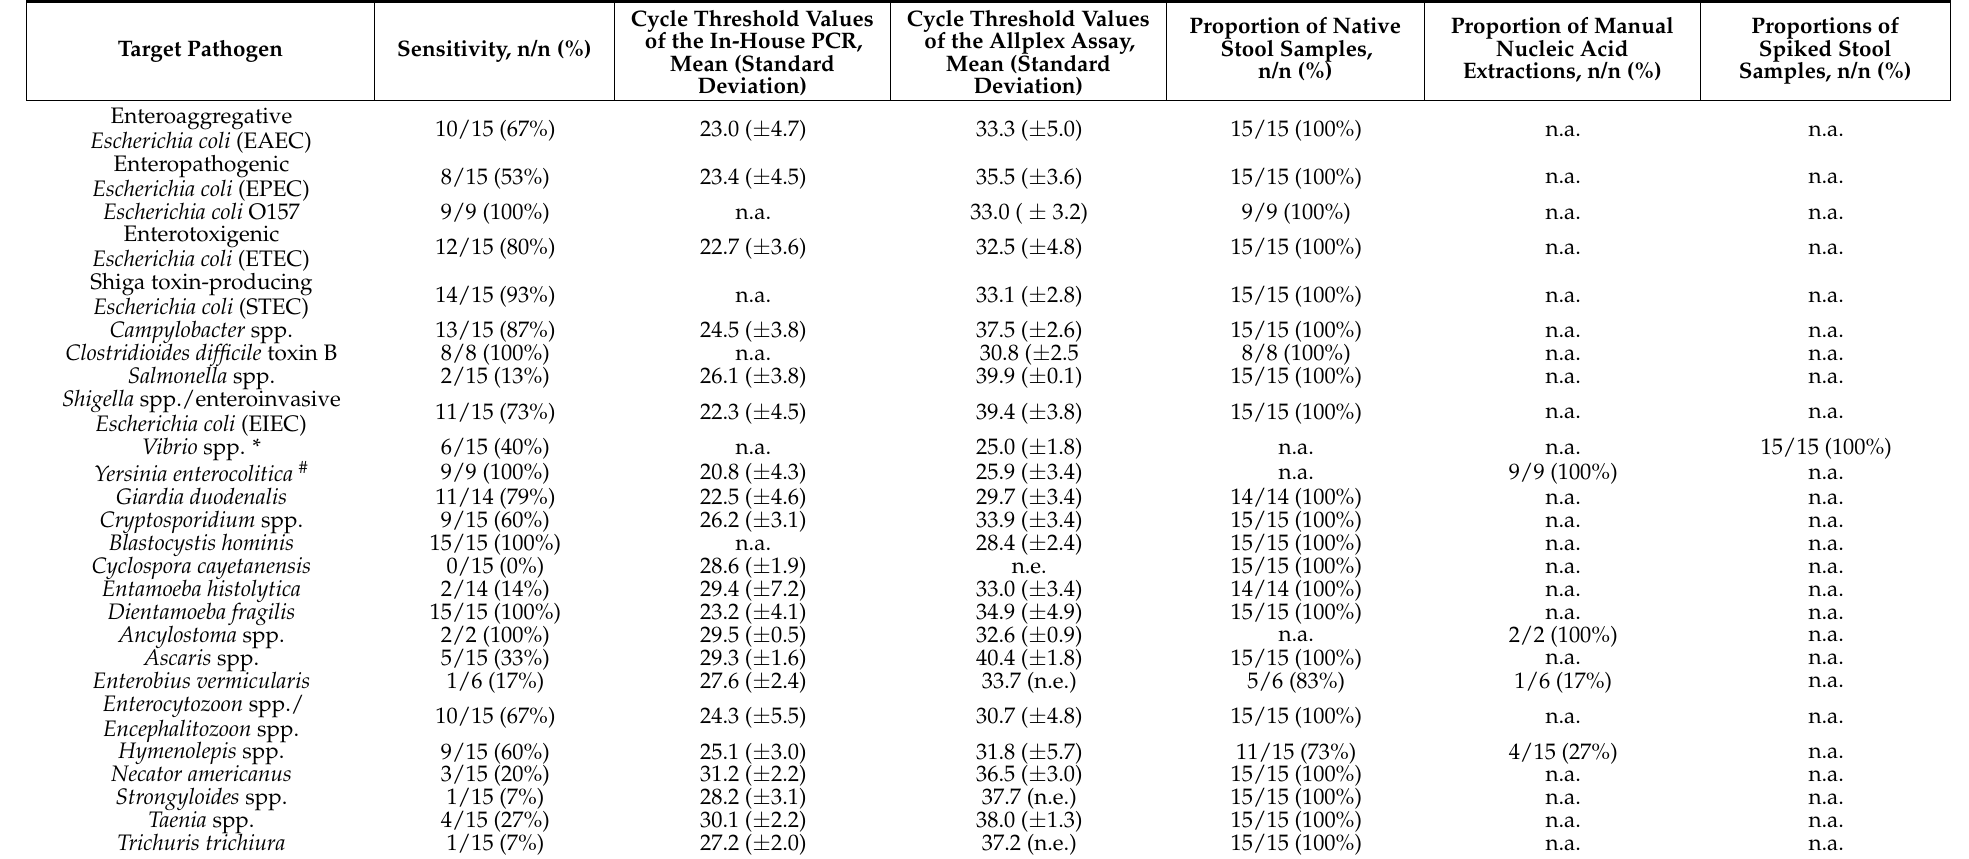
Table 1. Results of the assessments with strongly positive samples. Calculated sensitivity values refer to the applied reference standards as described in the Methods